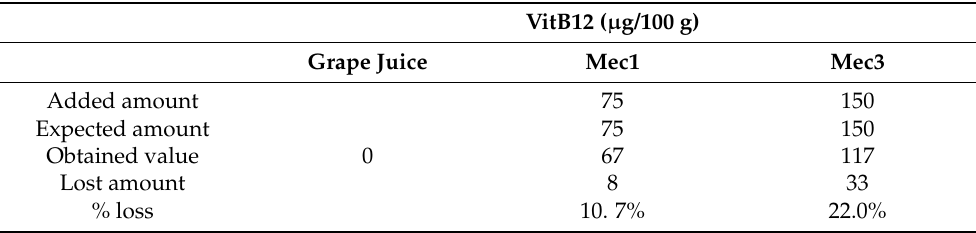
Table 3. Vitamin B12 levels in original grape juice, and in Mec1 and Mec3 samples.